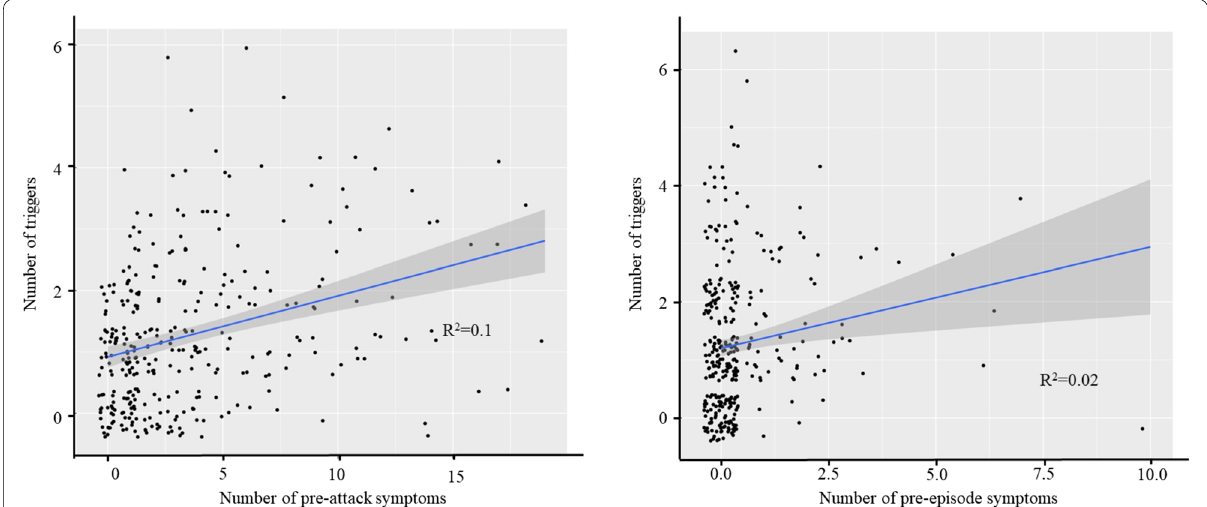
Fig. 5 The left shows the correlation of number of triggers to number of PAS; the right shows the correlation of number of triggers to number of PES